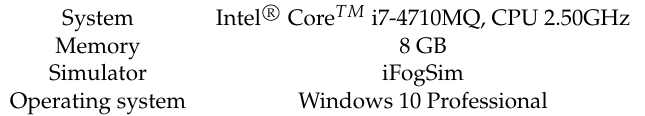
Table 5. Simulation setup.